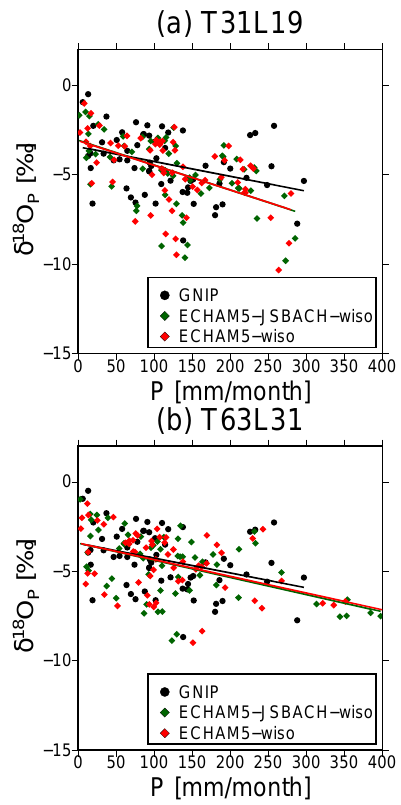
Fig. 6. Comparison of the simulated δ 18 O P – P relation of ECHAM5-JSBACH-wiso (noF) with ECHAM5-wiso for the res- olutions (a) T31L19 and (b) T63L31. For comparison with the ob- served relation, we use data from those GNIP stations where the annual mean temperature is above or equal to 20 ◦ C. (Please note that the linear fits of ECHAM5-JSBACH-wiso experiment (green line) and ECHAM5-wiso experiment (red line) are almost identical and strongly overlap in the